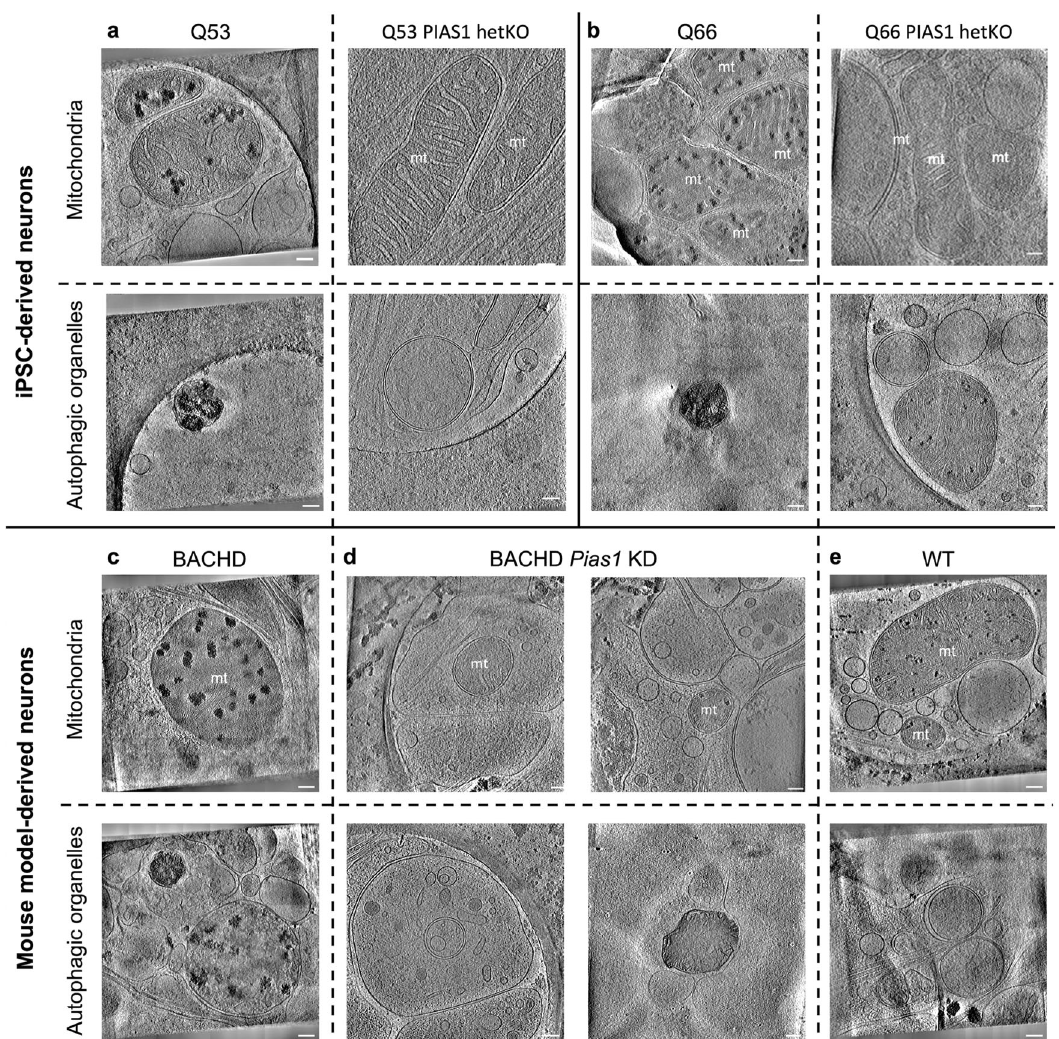
Fig. 8 | Effects of reduced PIAS1/Pias1 on mitochondrial granule size and sheet aggregates in autophagic organelles in neurites of HD model neurons. Slices (~1.4nm thick) through representative cryoET tomograms of neurites in a Q53 and b Q66HDiPSC-neuronswithout(left)andwith(right) PIAS1 hetKOshowthat PIAS1 hetKO ameliorated the phenotypes of enlarged mitochondrial granules ( fi rst row) and sheet aggregates in putative autophagic organelles (second row). Slices